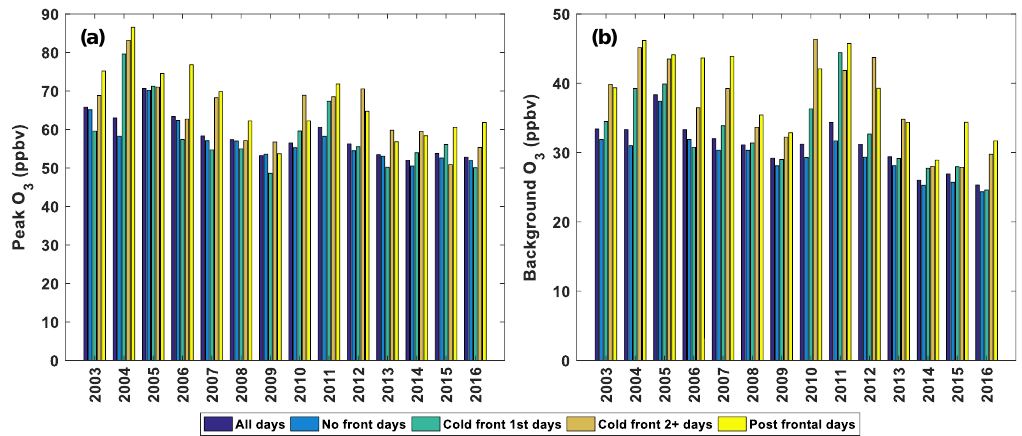
Figure 5. Annual time series of average ( a ) peak O 3 and ( b ) background O 3 mixing ratios.